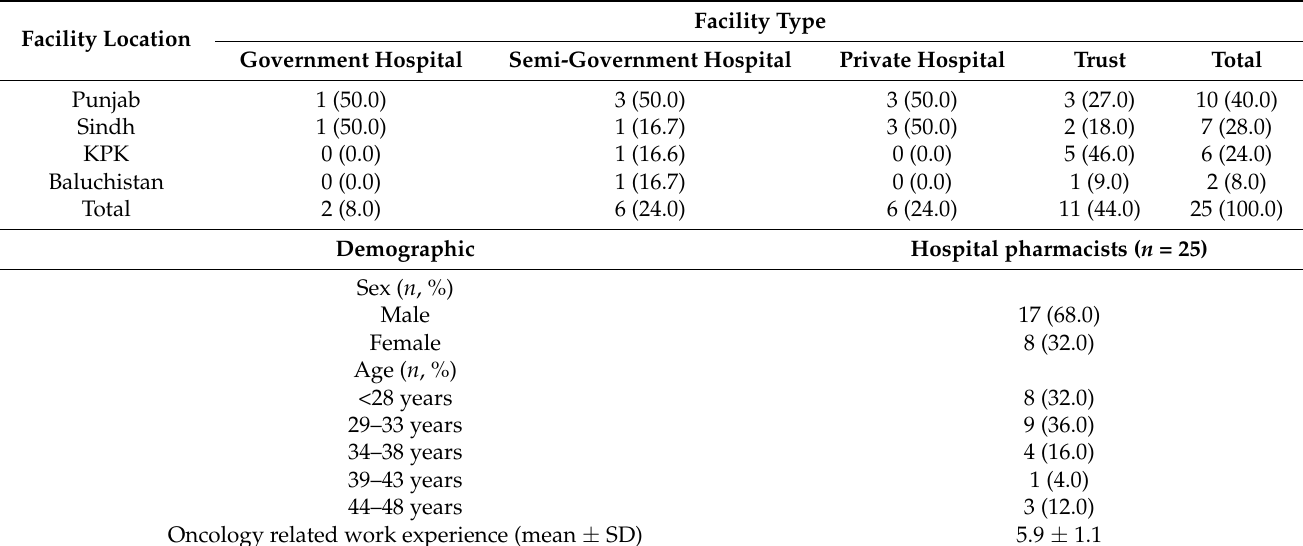
Table 1. Response rate per province and the characteristics of interviewees, n